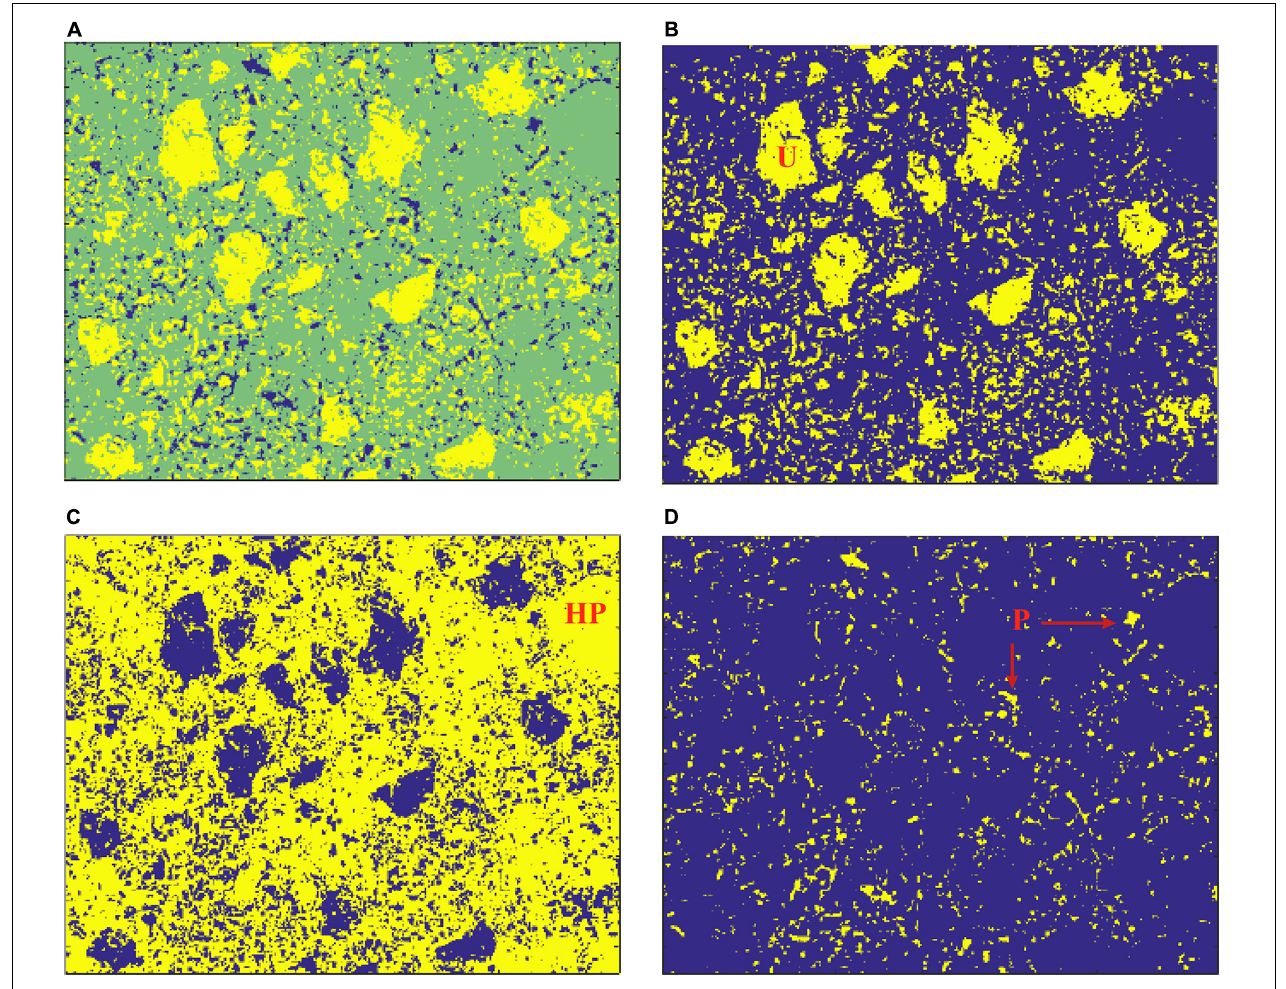
FIGURE 7 | (A) Segmented image. (B) Anhydrous. (C) Hydration products. (D)